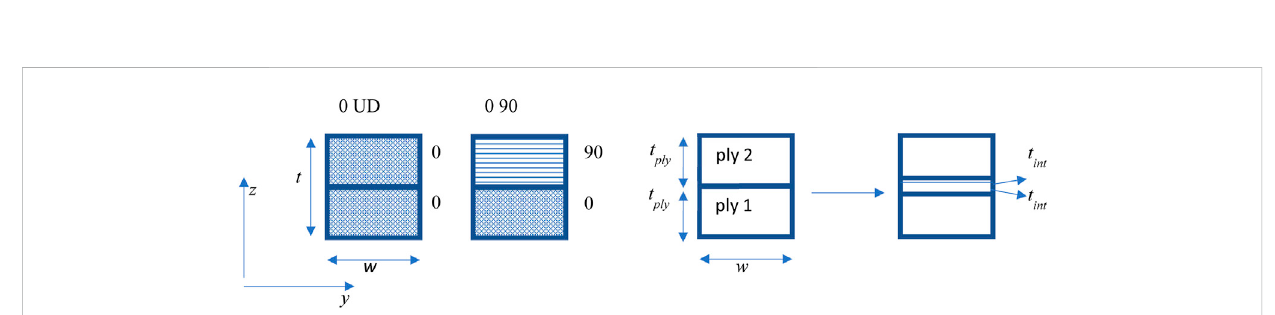
FIGURE 2 Front viewofthesmall2-plylaminate sample. AUD[0,0]andacross-ply[0,90]laminateareshown. The0 fi bersareoriented in x -direction.Eachply has a total thickness t ply . The cross-ply interface layer of arbitrary fi nite thickness t int per ply is considered in between the ply. Hence, the interface layer thickness is 2* t int .